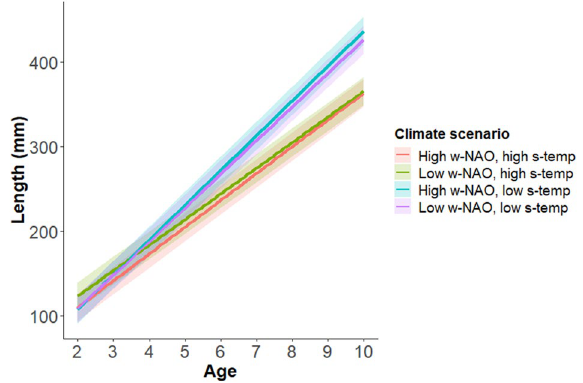
Figure 2. Predicted mean length in mm (y-axis) at age (x-axis) from the most supported growth model. The variation between the different lines illustrates differences in predicted mean length at age given four different combination of summer air temperature and winter NAO-index values. Low and high mean summer air temperature considered in the growth projections are 10.6 °C and 15.1 °C, respectively, while high and low w-NAO represents -0.82 and 1.85, respectively. Shaded areas show the standard deviation of the predicted mean length at age. The figure has been made using the ggplot2-library 68